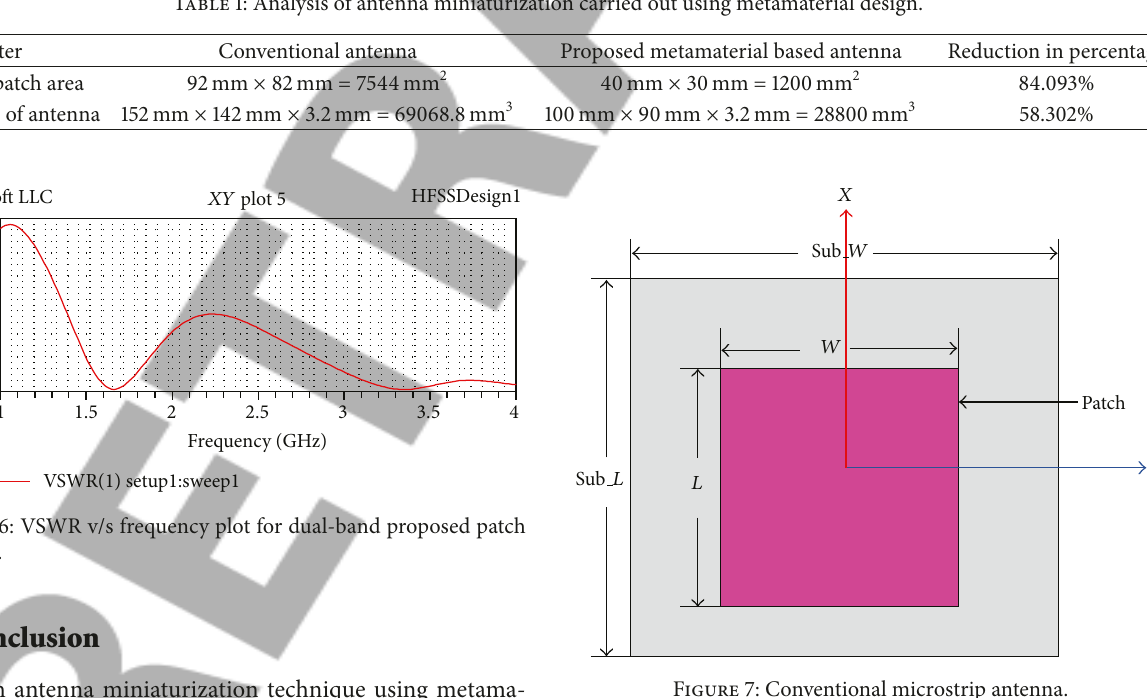
Figure 5: Radiation pattern (gain) of proposed patch antenna. Table 1: Analysis of antenna miniaturization carried out using metamaterial design.